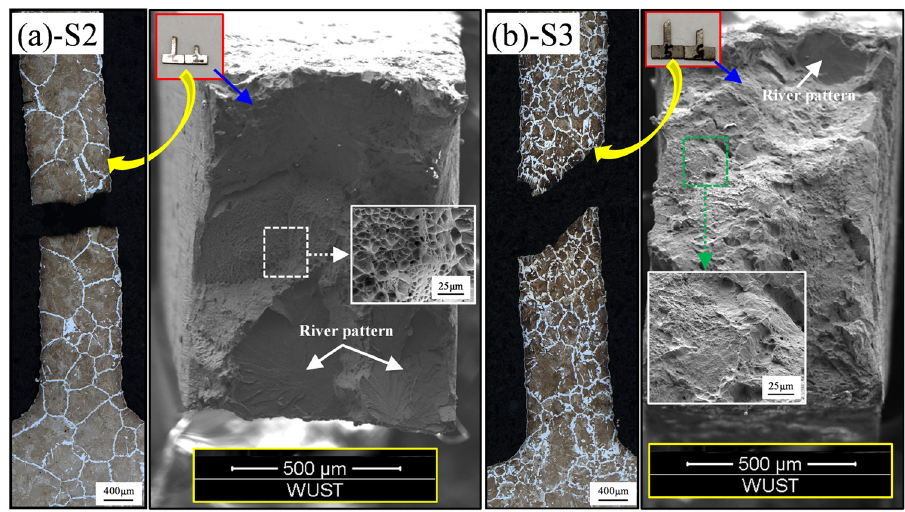
Figure 15: Macrostructure and microstructure of the tensile fracture for the ( a ) S2 and ( b ) S3